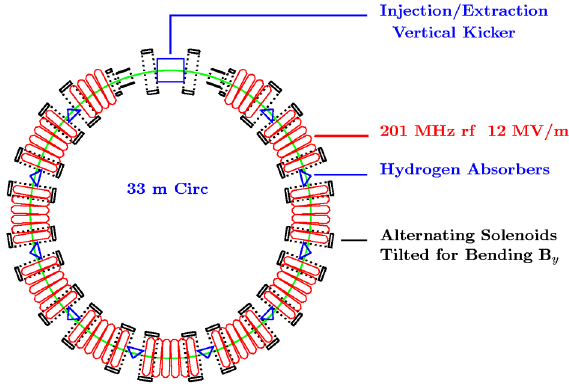
FIG. 37. (Color) Layout of an RFOFO cooling ring.